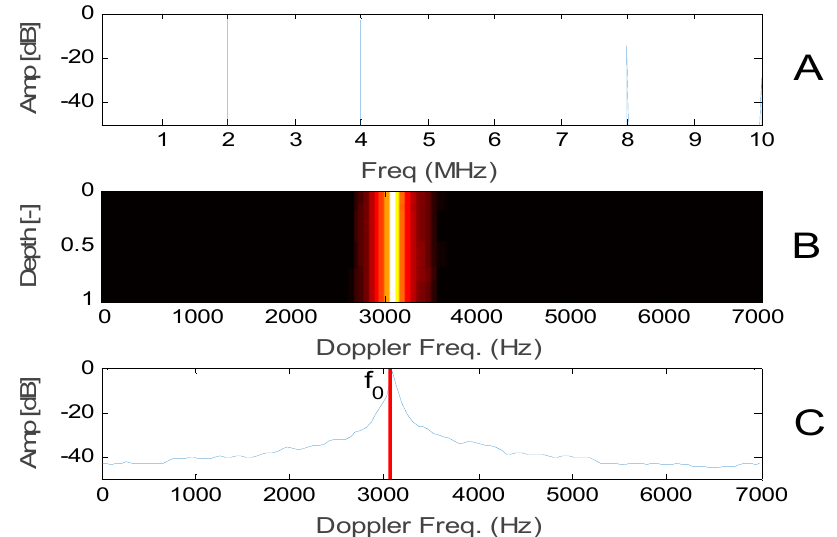
Figure 3. Simulation of the noise produced by a switching regulator working at 1.8 MHz in a Doppler system with T Pri = 142.86 µ s. ( A ) Spectrum of the noise as coupled to the input to the Doppler system; ( B ) Doppler spectral matrix; ( C ) spectral density averaged over depths ( k -index). The condition in Equation (18) is not met, and a noise artifact is clearly visible at f o = 3079.9 Hz.